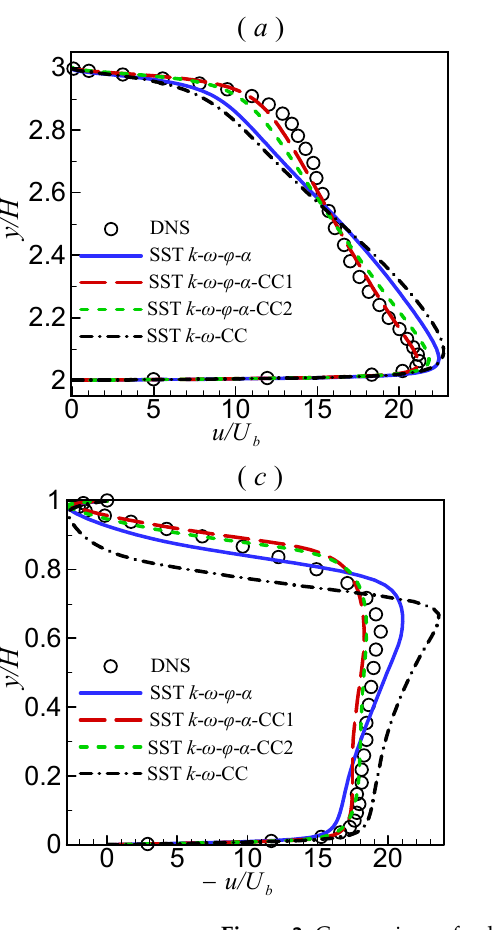
Figure 4. Comparison of friction coefficient distribution along the inner ( a ) and outer ( b ) walls. The performance of the turbulence models concerning predicting the re ‐ circulation can also be illustrated using the separation and re ‐ attachment points, as well as the re ‐ circulation length, which are listed in Table 1. It shows that all models predicted the sep ‐ aration point earlier and the re ‐ attachment point later. The original  ---k SST model and the CCSST --k  model enlarged the re ‐ circulation region dramatically; however, the two proposed models in the present paper obtained significantly improved results.